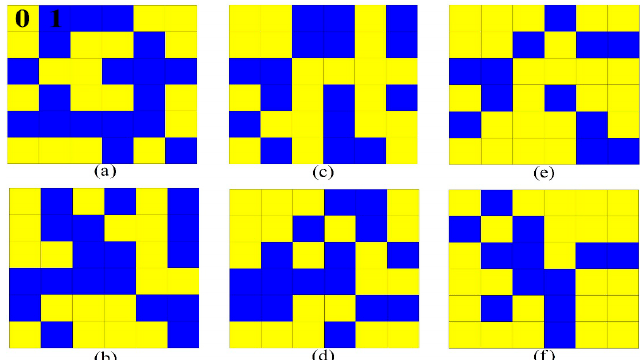
Figure 3. Arrangements of six matrix-type random coding MS: ( a , b ) coding a and b with the ratio α = m 0 / m 1 = 1/1; ( c , d ) coding c and d with the ratio α = m 0 / m 1 = 5/4; and ( e , f ) coding e and f with the ratio α = m 0 / m 1 = 2/1.